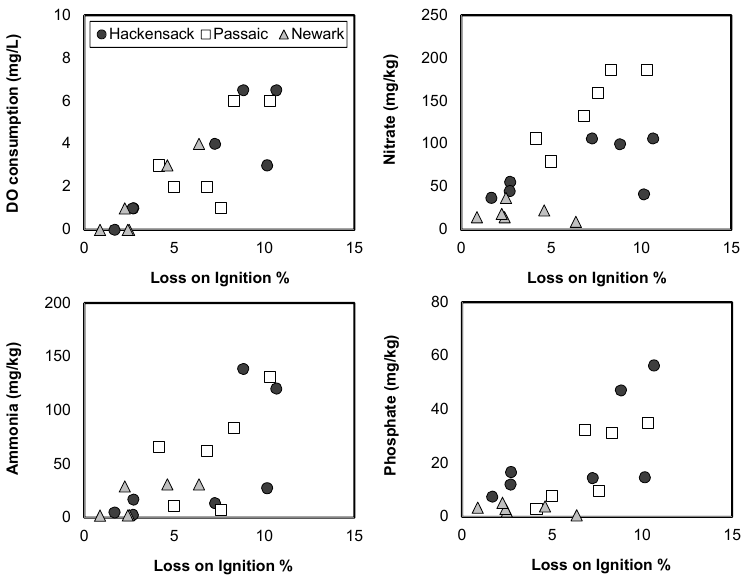
Figure 5. Correlation between organic matter content (Loss on Ignition %) and dissolved oxygen consumption as well as concentrations of mobilized nutrients in sediments collected from the Hackensack and Passaic Rivers as well as the Newark Bay in summer 2016.